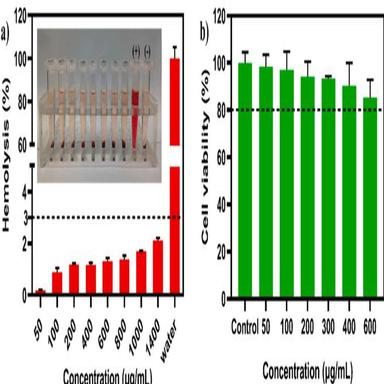
Biocompatibility of Fc-PP-POP. a) Hemolysis test of Fc-PP-POP; b) Cytotoxicity of Fc-PP-POP toward HEK 293 cells.